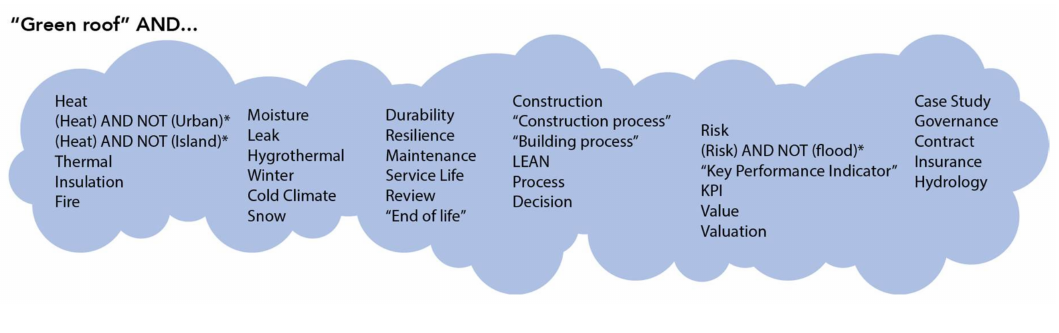
Figure 1. Keywords and -phrases used in literature search, on the form “’Green roof’ AND